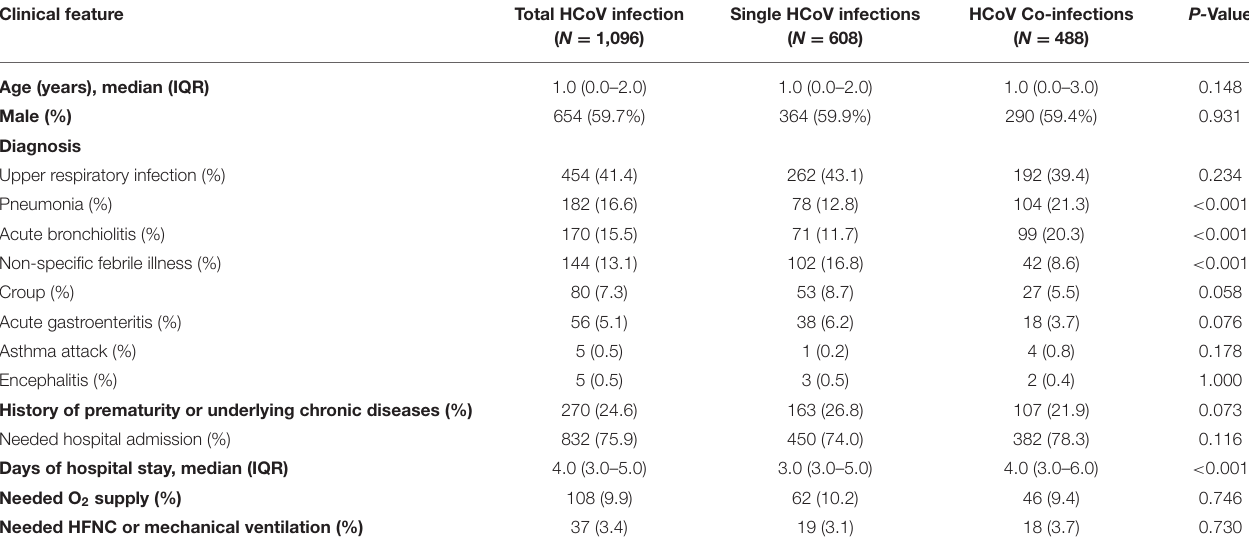
TABLE 4 | Clinical characteristics associated with HCoV infection: comparison between single infection and viral co-infection. Clinical